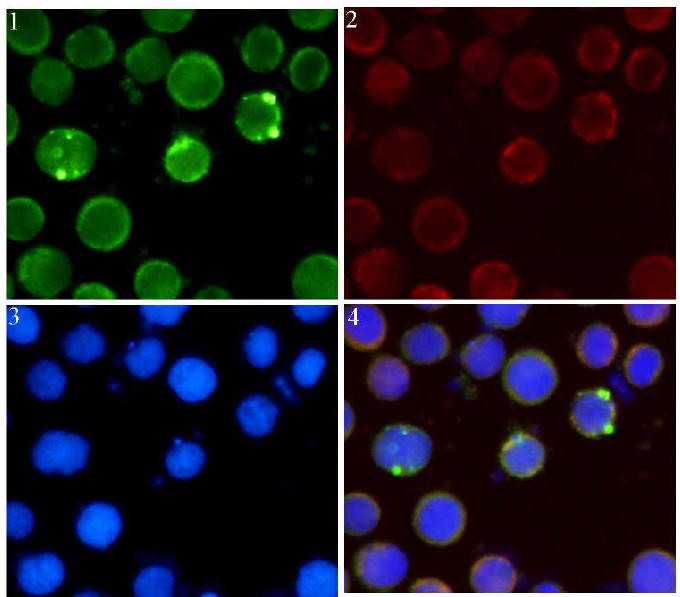
Figure 5. Subcellular localization of Sf-IBM1 and cytochrome c in Sf9 cells observed under a fluorescence microscopy ( 40×) . ( 1 ) The green fluorescence represented the recombinant protein IBM1. ( 2 ) The red fluorescence indicated the distribution of cytochrome c in Sf9 cells. ( 3 ) The blue fluorescence showed the nuclei stained with Hoechst 33258. ( 4 ) The figure merged with three fluorescence.